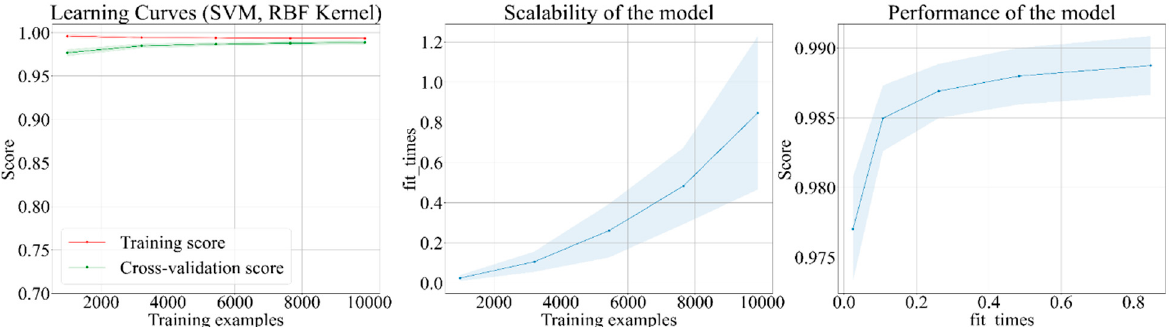
Figure 9. Training metrics of the optimized SVM classifier with a radial basis function (RBF) kernel. Table 1. SVM kernel parameter optimization .